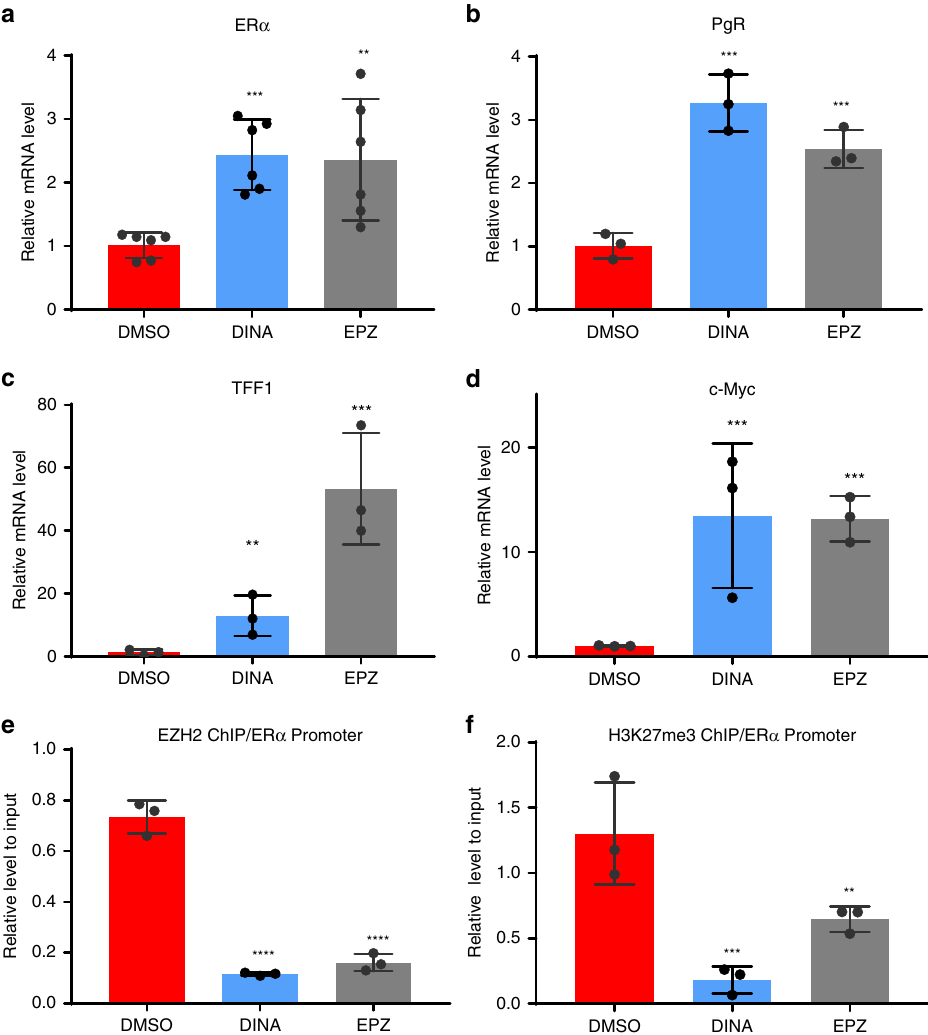
Fig. 3 EZH2 directly targets the promoter of ER α gene ( ESR1 ). a Under 3D culture conditions, MDA-MB-231 cells were treated with DMSO, dinaciclib (Dina) or EPZ-6438 (EPZ) for 3 days. The cells were collected to extract RNA. ER α expression was determined by real-time RT – PCR. Data were expressed as mean ± SEM ( n = 6). b – d ER α target gene expressions were determined by real-time RT – PCR for RNA from Fig. 3 a . Data represent mean ± SEM ( n = 3). e Chromatin immunoprecipitation (CHIP) assay using anti-EZH2 antibody to detect binding of EZH2 to ER α promoter regions. The immunoprecipitates were isolated from 3D cultured cells treated with DMSO, Dinaciclib or EPZ-6438. Data are representative binding to ER promoter relative to input control (mean ± SEM, n = 3). f CHIP assay using anti-H3K27me3 antibody to detect binding of H3K27me3 to ER promoter regions. The immunoprecipitates were isolated from 3D cultured cells treated with DMSO, Dinaciclib or EPZ-6438. Data are binding to ER promoter relative to input control (mean± SEM, n = 3). ** p < 0.05; *** p < 0.01; **** p < 0.001, Student ’ s t test. Source data are provided as a Source Data fi